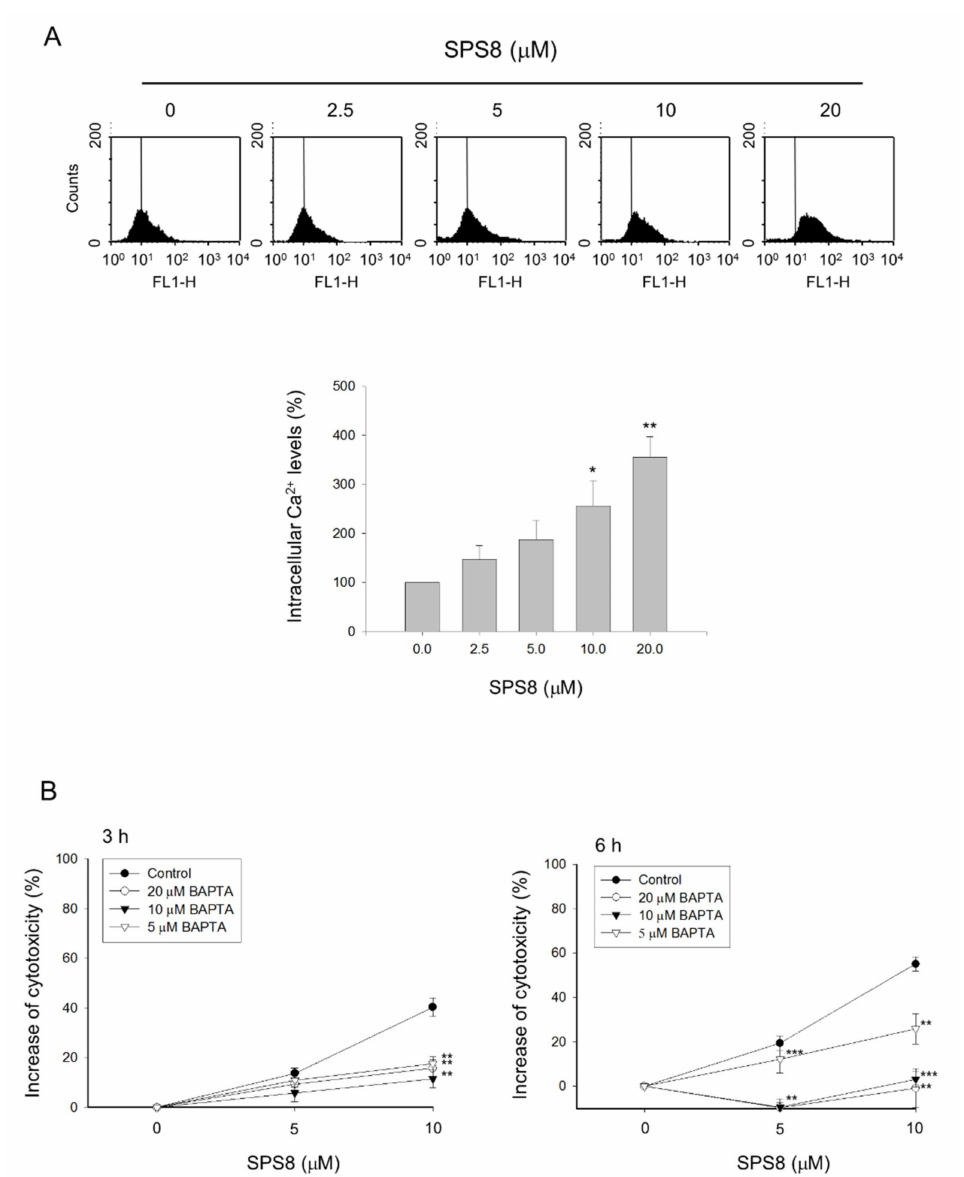
Figure 4. E ff ect of SPS8 on intracellular calcium levels of HL-60 cells. ( A ) HL-60 cells were incubated in the absence or presence of SPS8 at the indicated concentrations for 30 min. The intracellular Ca 2 + levels were measured by a flow cytometric analysis using fluo-3 / AM staining. *** p < 0.001 compared with zero micromolar control. ( B ) HL-60 cells were incubated in the absence or presence of the indicated agent for 3 or 6 h, and the cytotoxic e ff ect was determined by an MTT assay. Data are expressed as the mean ± SEM of three independent experiments. * p < 0.05, ** p < 0.01 and *** p < 0.001 compared with the BAPTA-free